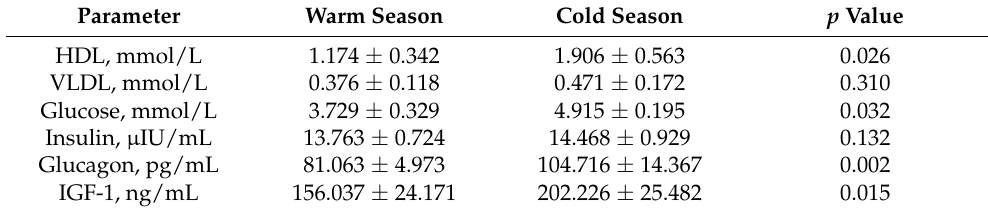
Table 4. Changes in serum biochemical parameters in grazing Mongolian sheep.